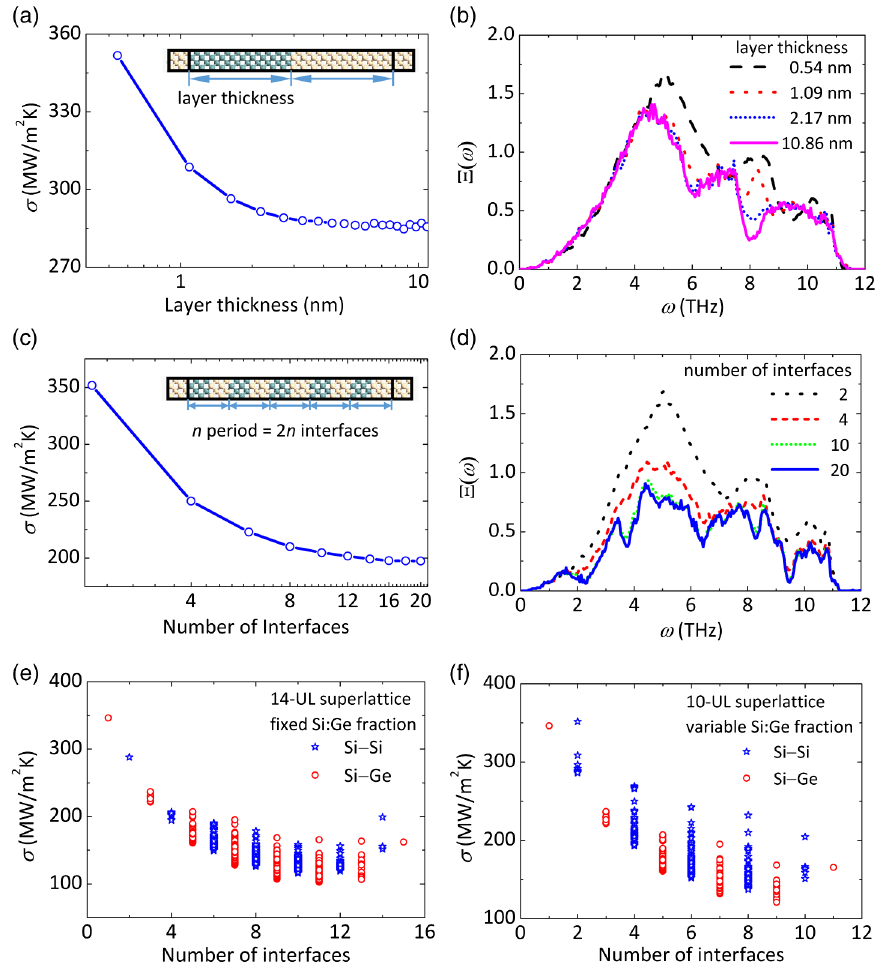
FIG. 5. (a),(b) ITC and phonon transmission versus the layer thickness. (c),(d) ITC and phonon transmission versus the number of interfaces with layer thickness of 1 UL, where 1 UL is 5.43 Å thick. (e),(f) ITC versus number of interfaces for cases of 14-UL superlattice with equal Si = Ge layer number and 10-UL superlattice with variable Si = Ge